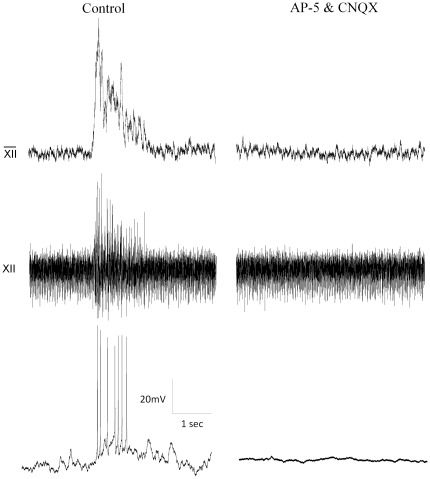
GABAergic inspiratory nonpacemaker cells fire in bursts that are blocked by CNQX and AP-5.GABAergic neurons fire bursts of action potentials during inspiration. Cells were patch clamped in the current clamp configuration with a small amount of current when needed (<30 pA) injected to hold it at −65 mV. Inspiratory activity was measured from the hypoglossal rootlets (top two traces). Respiratory activity was greatly reduced in this population of cells. (Control: 1.7+/−0.4 Hz; CNQX & AP5: 0.2+/−0.3 Hz; p<0.05).